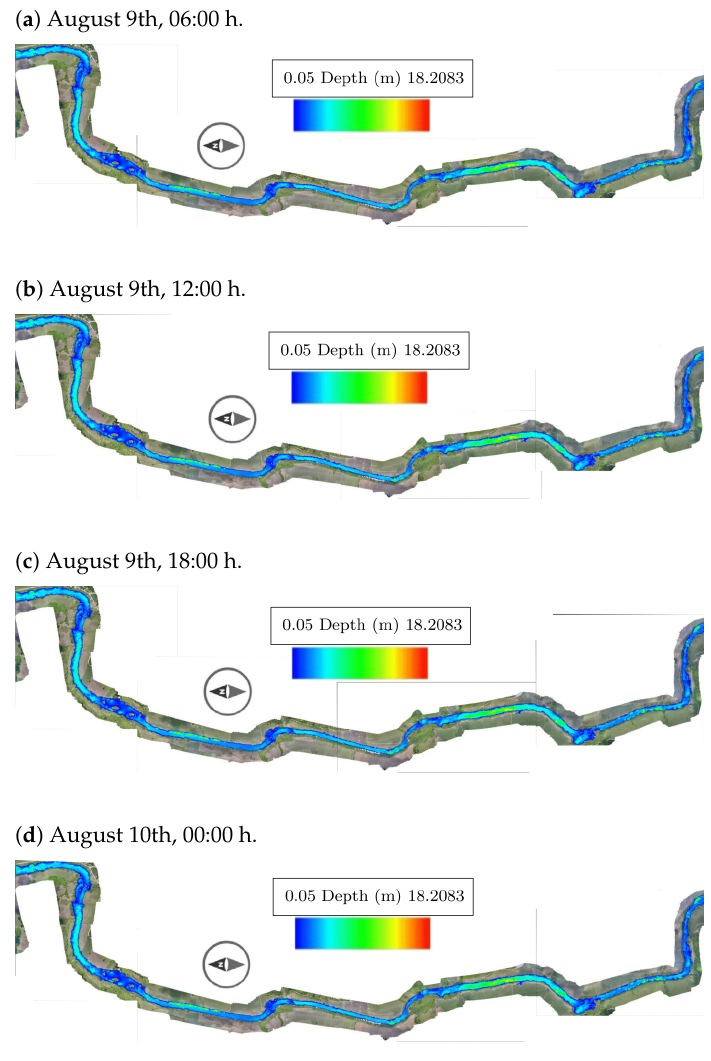
Figure 16. Depths for scenario